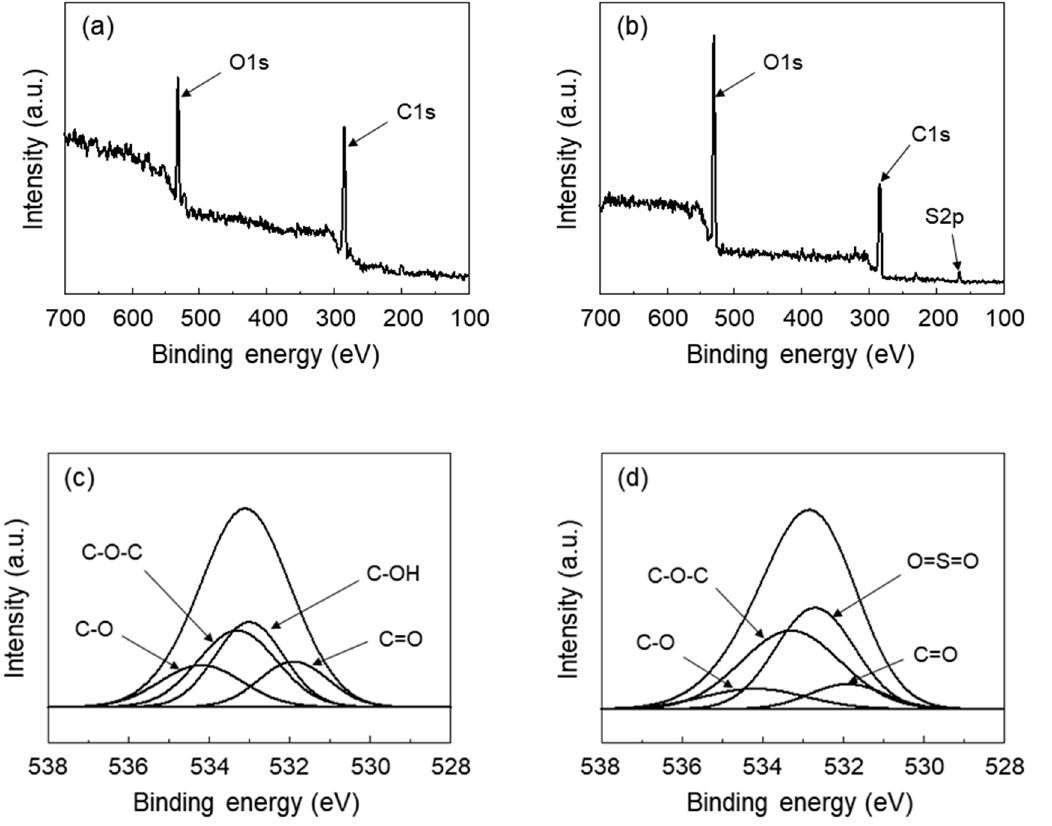
Figure 2. Wide region XPS spectra of ( a ) graphene oxide (GO) and ( b ) sulfonated graphene oxide (SGO). Deconvoluted XPS spectra in the O 1s region for ( c ) GO and ( d ) SGO.